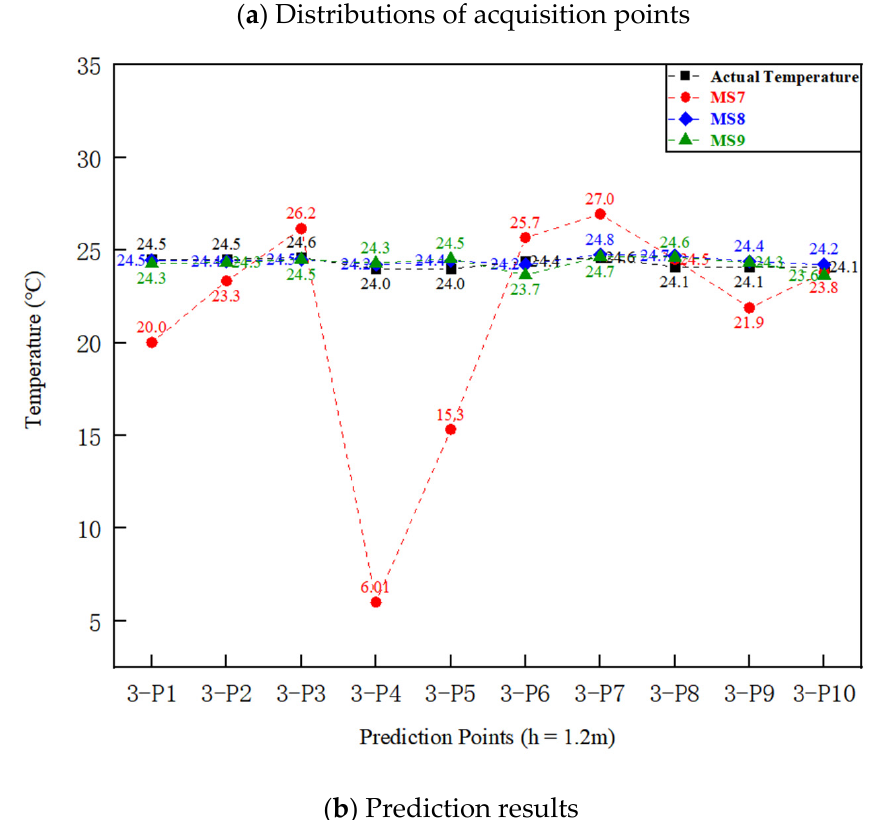
Figure 13. Prediction of mobile sensors with acquisition distance of 3.0 m.